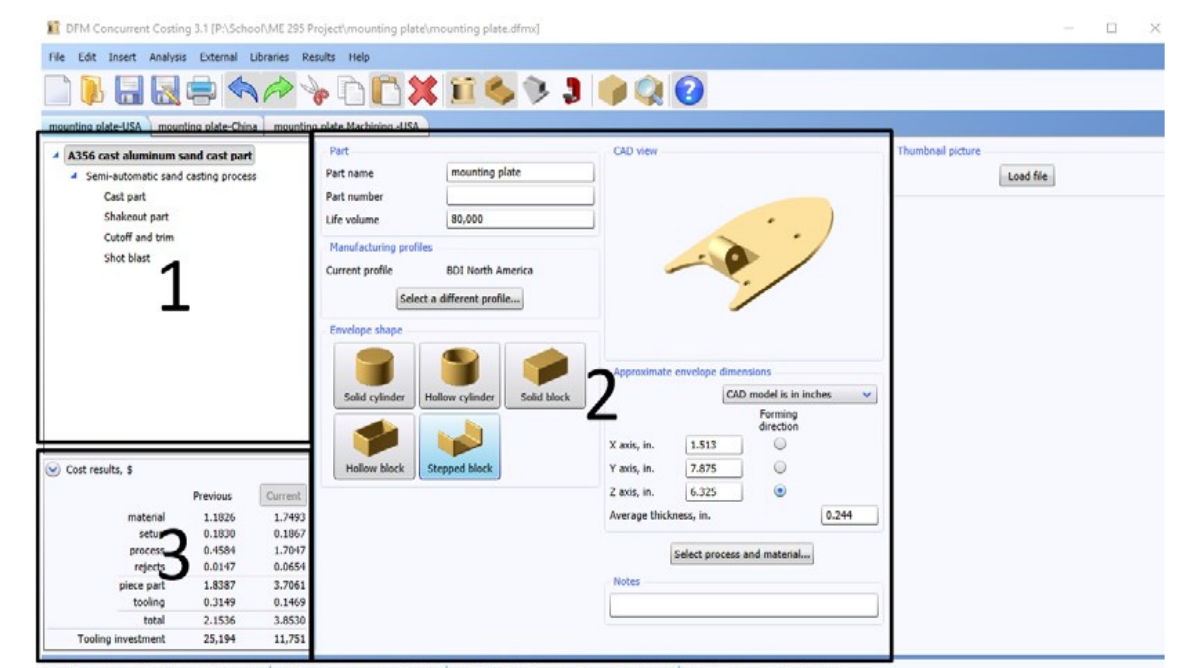
Figure 16. DFM of mounting plate.